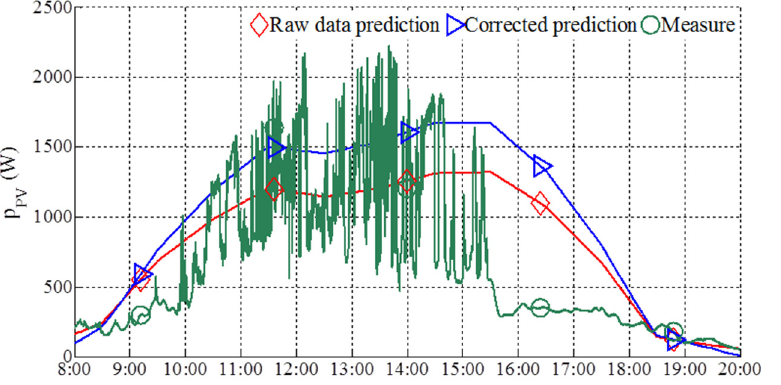
Figure 10. PV sources power prediction and actual PV sources power measure for Test 2.